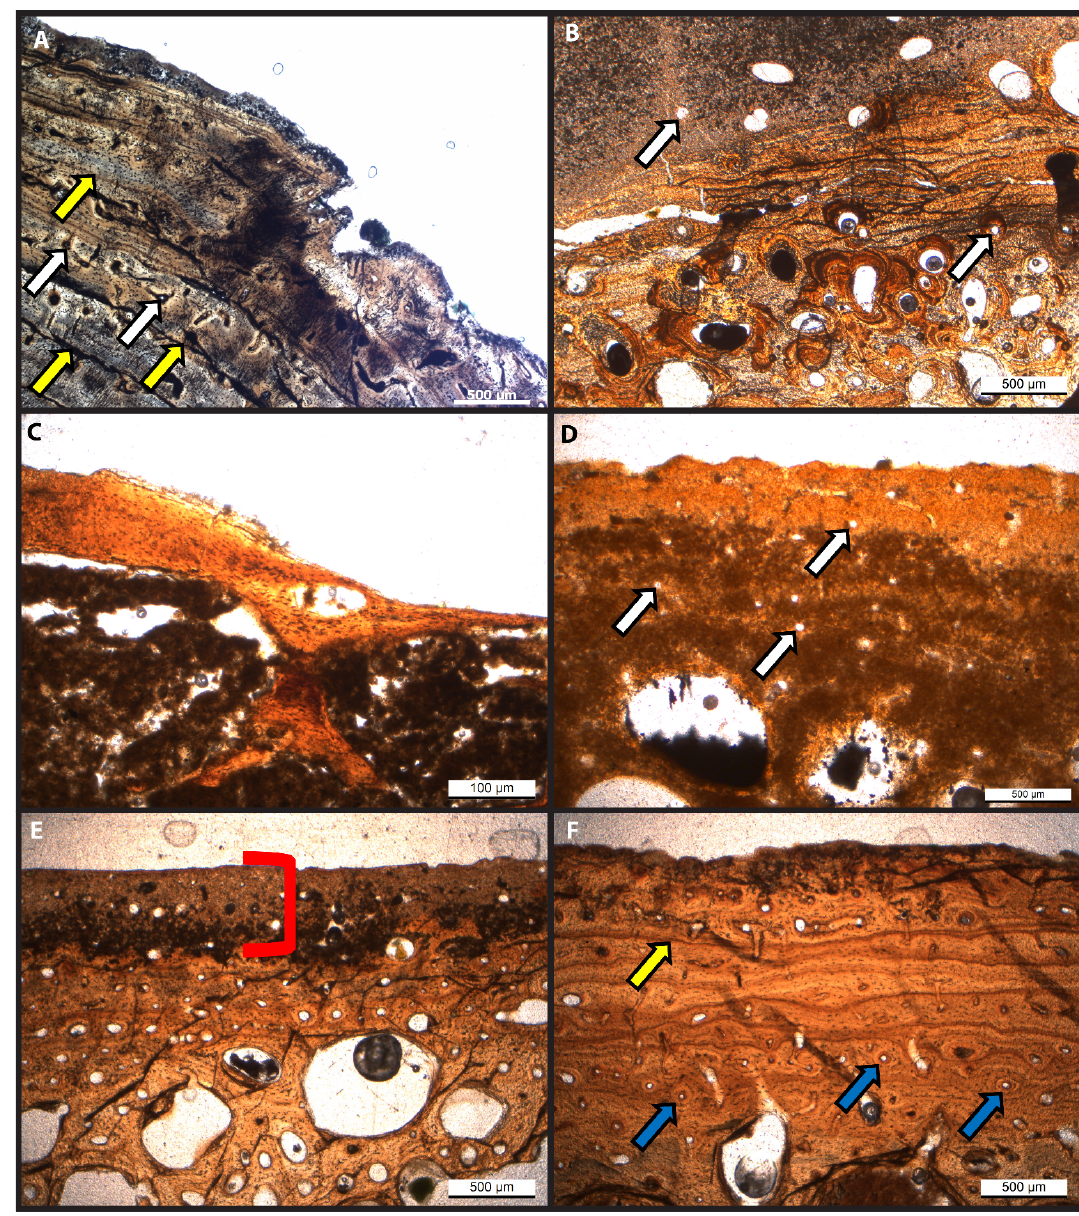
Figure 1. Thin sections of specimens used for demineralization illustrate the varying degrees of bone microstructure preservation. ( A ) Thoracosaurus femur (RU-EFP-00006-11) femur showing well- preserved bone microstructure including Sharpey’s fibers (Histologic Index [HI] = 5). ( B ) Indeter- minate crocodilian tibia (RU-EFP-00030) showing little bone microstructure preserved (HI = 1). ( C ) Euclastes costal prong (RU-EFP-00018) showing excellent preservation (HI = 5). ( D ) Taphrosphys peripheral (RU-EFP-02175) showed very poorly preserved microstructure (HI in this region = 1; HI for the entire thin section = 2). ( E ) Indet. Pan-Cheloniid peripheral (RU-EFP-02245) showed well preserved internal cortex but a highly altered outer cortex (HI = 4). ( F ) Juvenile Taphrosphys costal (RU-EFP-02222) with well-preserved microstructure (HI of this region and the entire thin section = 4–5). White arrows indicate vascular canals, yellow arrows indicate lines of arrested growth, and blue arrows indicate primary osteons. The red bracket corresponds to external rims of light color and poor histological integrity. Collagen I, a structural protein abundant in bone tissue, was selected as the primary target for biomolecular investigation in this study because of its high preservation